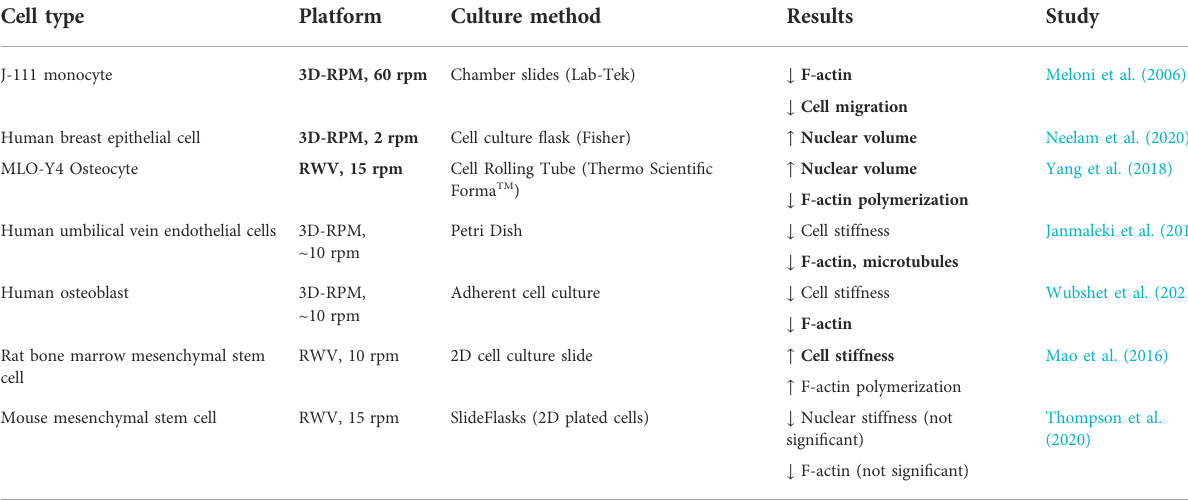
TABLE 1 Simulated microgravity alters nuclear and cytoskeletal structural dynamics in various cell types and culture methods. Boldened results indicate concordance with observed space fl ight microgravity motility studies. Although in the fi eld of cell adhesion and migration, the generalized effect of cell mechanical characteristics is still unclear (Mierke, 2021). The nucleus is the stiffest organelle and contributes the most to cellular stiffness (Qi et al., 2016). Increased actin polymerization generally increases nuclear size and stiffness via nucleoskeletal remodeling (Liu et al., 2019), thus reducing cellular motility (McGregor et al., 2016). Generally, cell motility is reduced in space fl ight and simulated microgravity across various cell types (Meloni et al.,